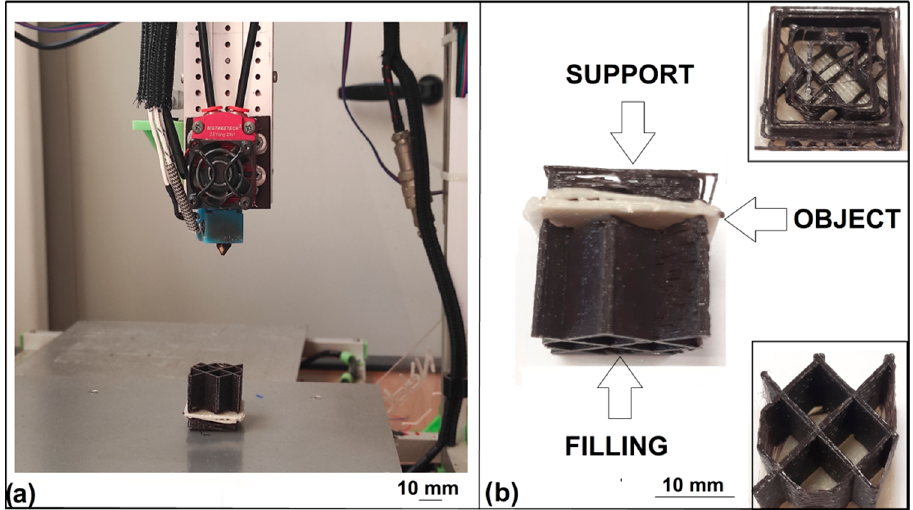
Figure 8. ( a ) Representative sample printed with the 3DPRN LAB printer; ( b ) 3D printed representative sample components and details.